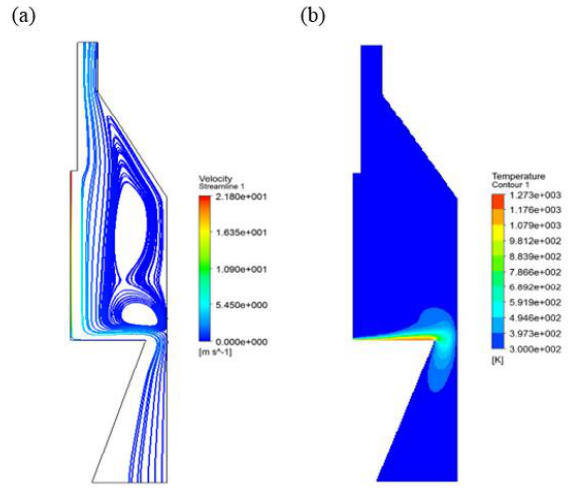
Figure 13. Schematic diagram of for Experiment 1, Case 1 ( a ) flow field and ( b ) thermal field.